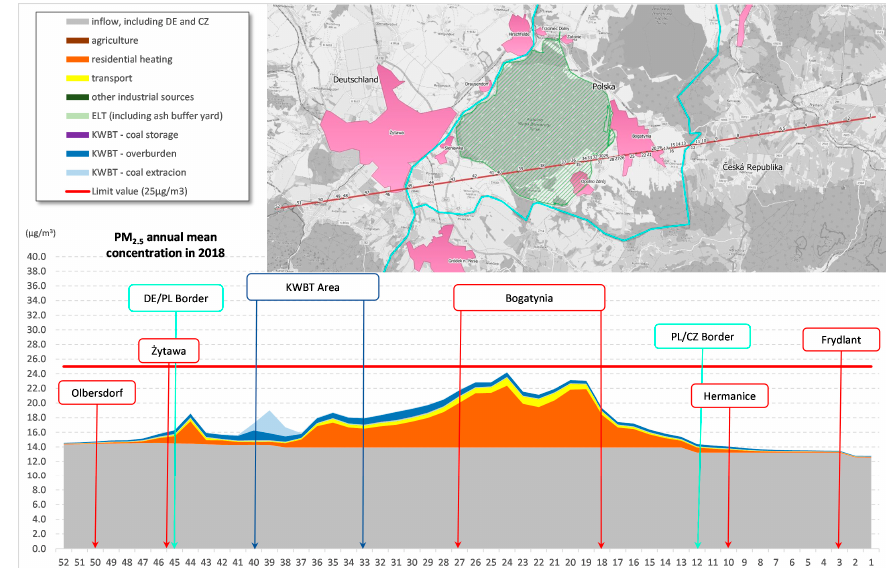
Figure 24. Profile of annual mean concentrations of PM 2.5 between Olbersdorf and Frydlant, considering the shares of individual source groups in 2018 (source: own study).